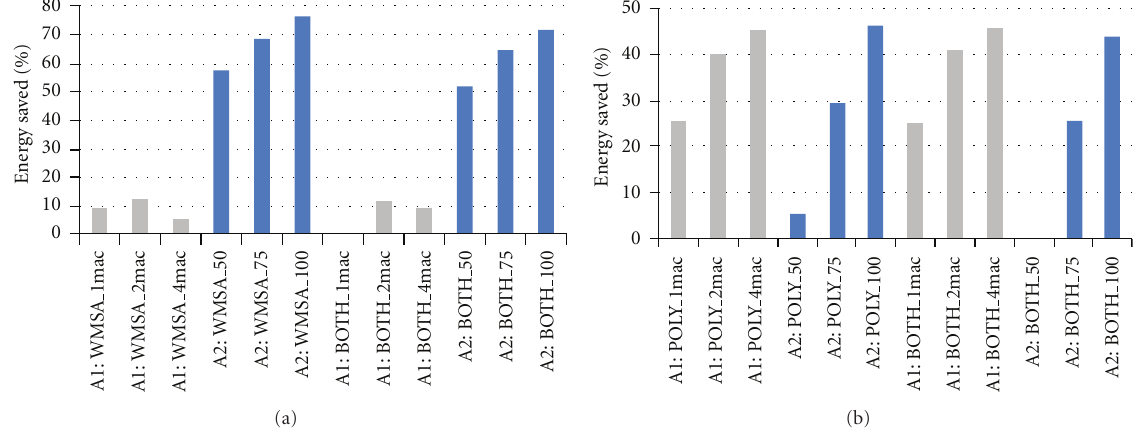
Figure 17: 32-bit: Energy savings in percent for A1 versus A2, normalized to worst case. WMSA (a), PI (b).